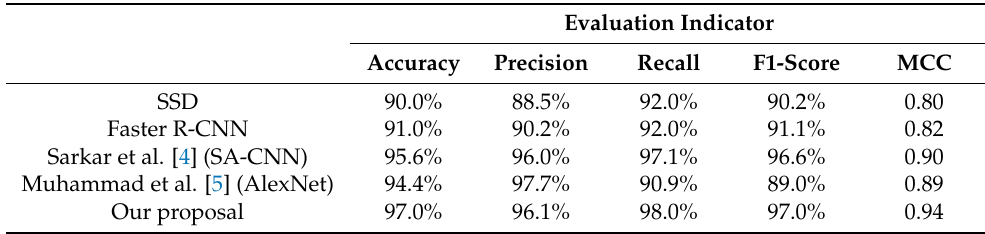
Table 4. Evaluation result for each detection